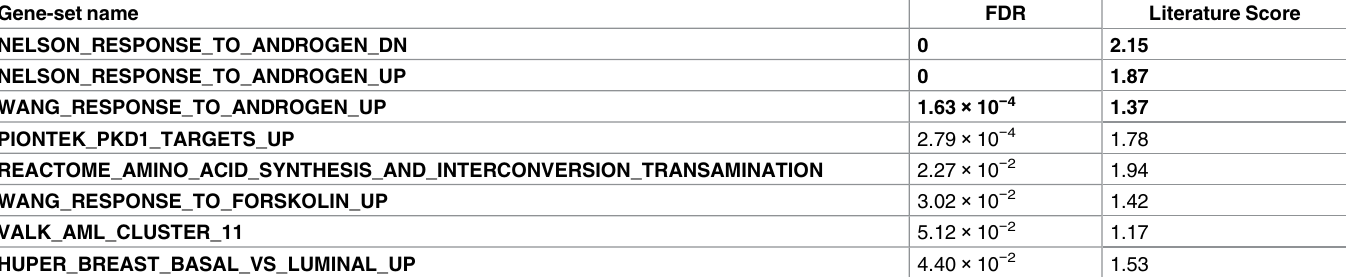
Table 1. Significant gene-sets detected by the absolute GSEA-GP filtering (FDR < 0.1)with the mod- t score (DHT-treated and control LNCaP cell